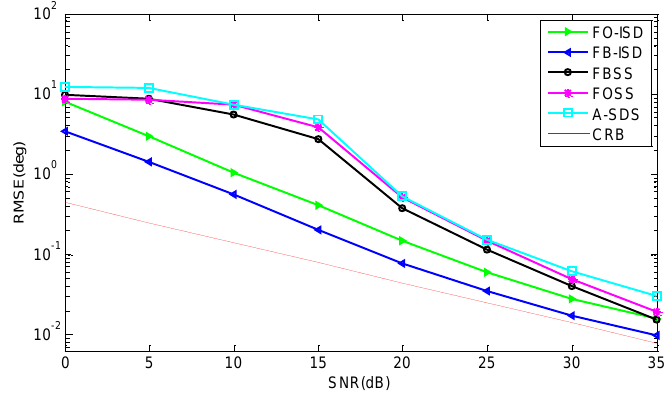
Figure 8. RMSE curves versus the SNR in the colored noise condition.